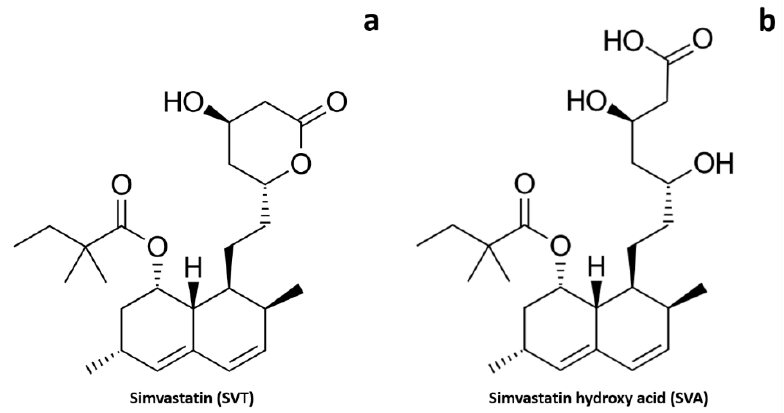
Figure 1. Chemical structures of simvastatin ( a ) and simvastatin hydroxy acid ( b ).